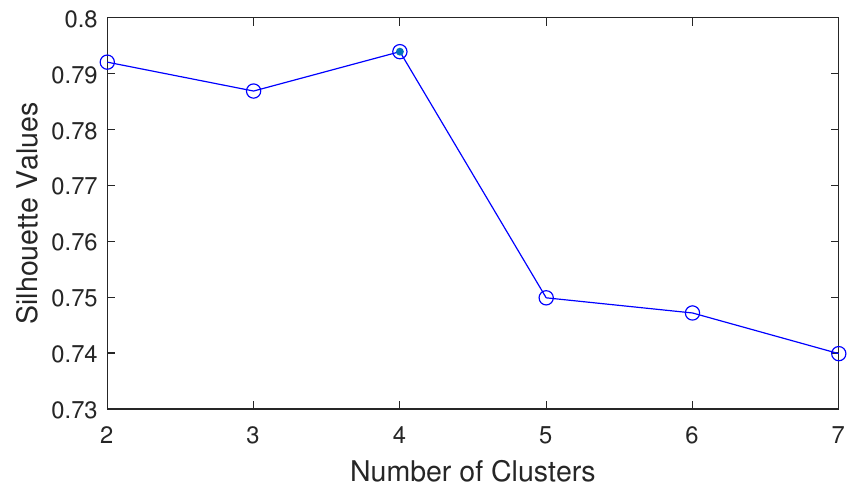
Figure 11. Silhouette value evaluation for the